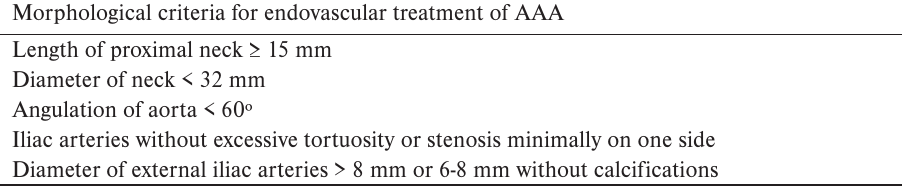
Table 2. Morphological criteria for standard endovascular treatment of